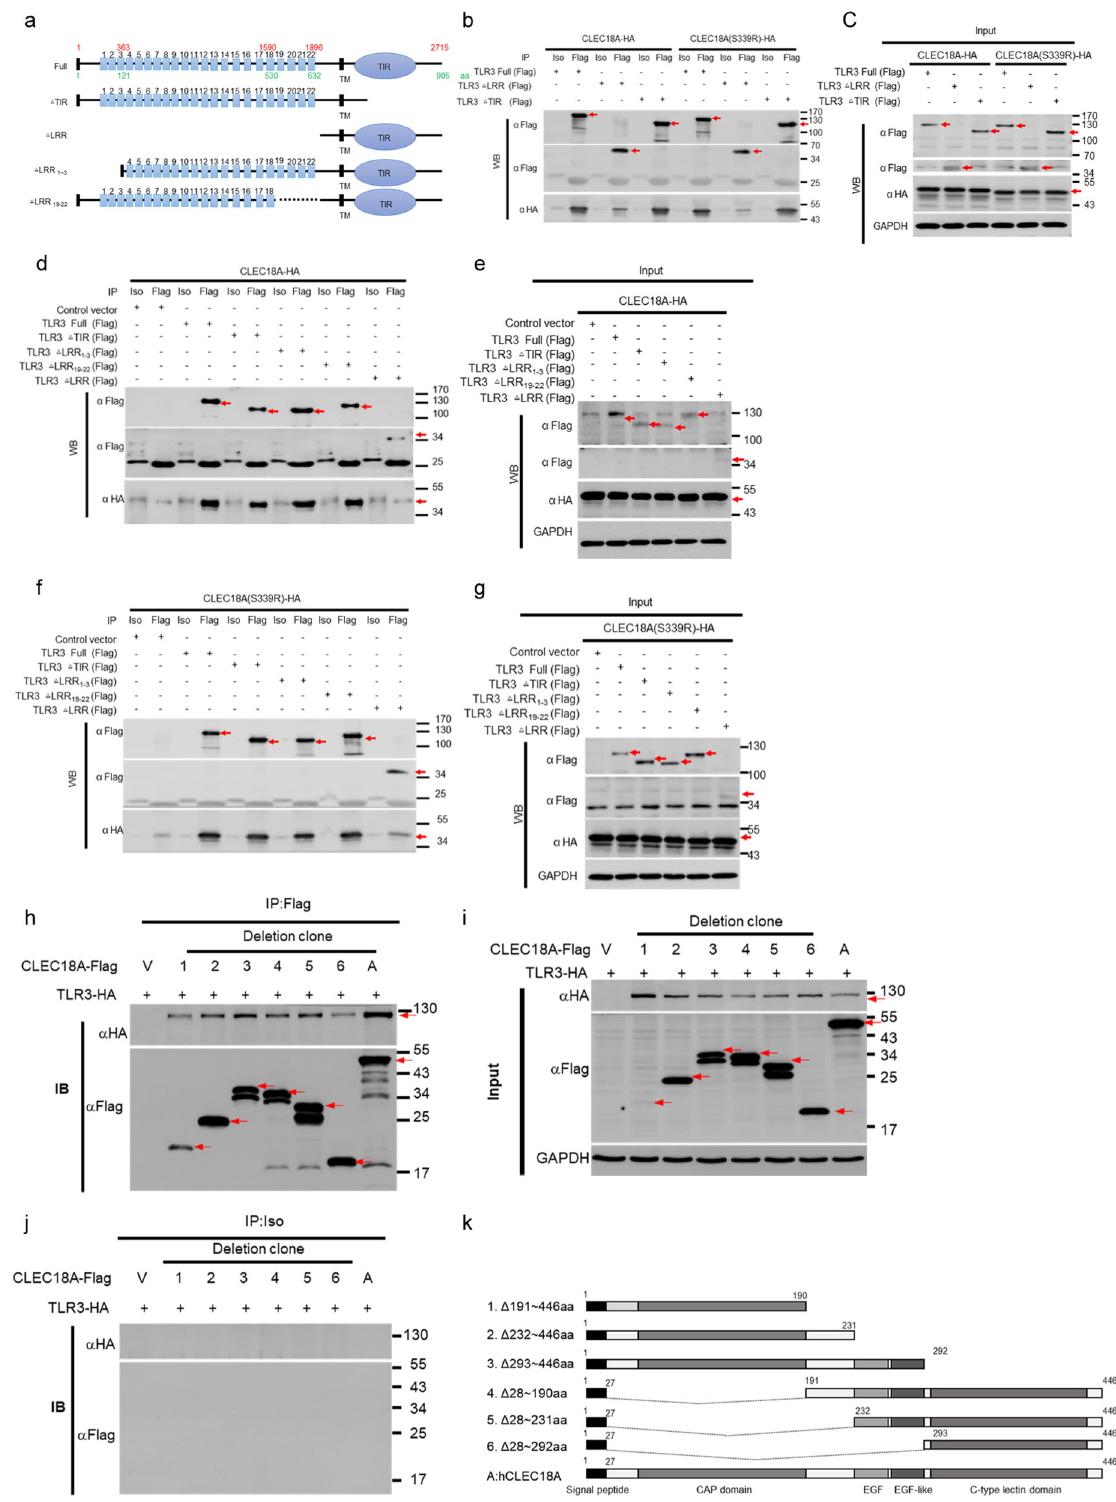
SI04149502), AllStars Negative Control siRNA (Qiagen, 1027280), and AllStars Neg.siRNA AF 488 (Qiagen, 1027289). Mice . Eight to twelve-week-old WT C57BL/6 and ROSA-CLEC18 mice were used for all the experiments. The ROSA-CLEC18A and ROSA-CLEC18A(S339R) knock-in mice were generated by the Transgenic Mouse Models Core. All animals were bred and housed at the Academia Sinica SPF animal facility and